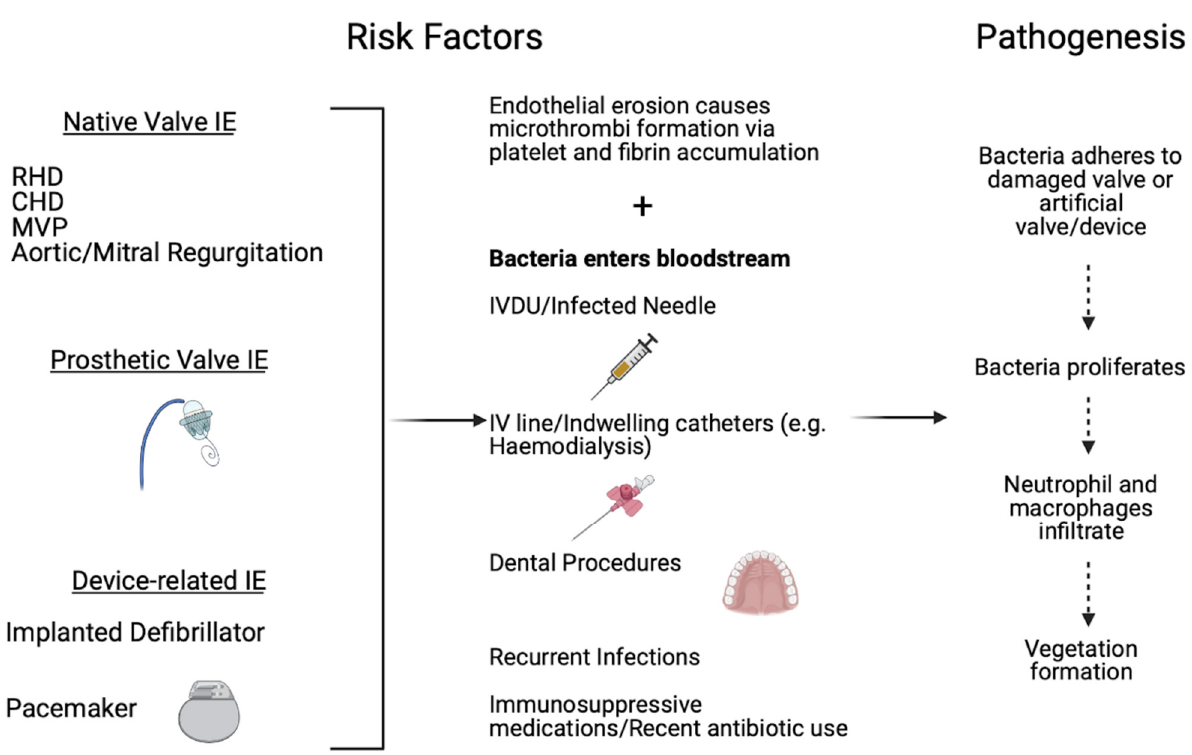
Figure 1. Risk factors and pathogenesis of infective endocarditis, Abbreviations: IE: Infective endocarditis; RHD: Rheumatic heart disease; CHD: Congenital heart disease; MVP: Mitral valve prolapse; IVDU: Intravenous drug user; IV: Intra- venous.